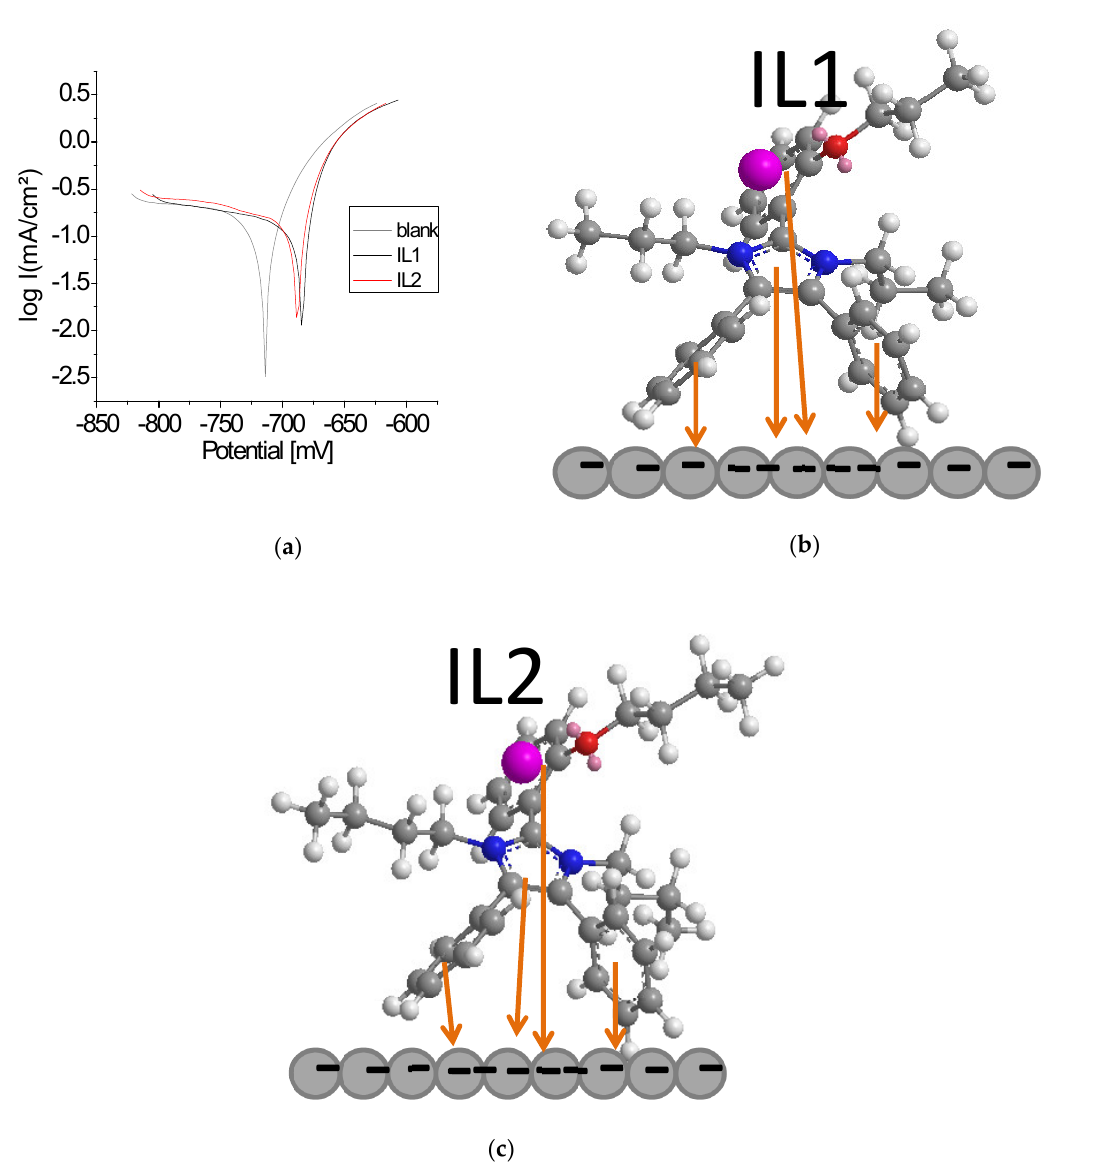
Figure 7. ( a ) Extrapolation Tafel curve of IL1 and IL2 and ( b ) the 3D visualization illustration of the interaction between IL1 and ( c ) IL2 on the carbon steel surface (note: the red ball reflects the oxygen atom, the blue ball reflects the nitrogen atom, the purple ball reflects the iodine atom, the grey ball reflects the carbon atom, and the white ball reflects the hydrogen atom).